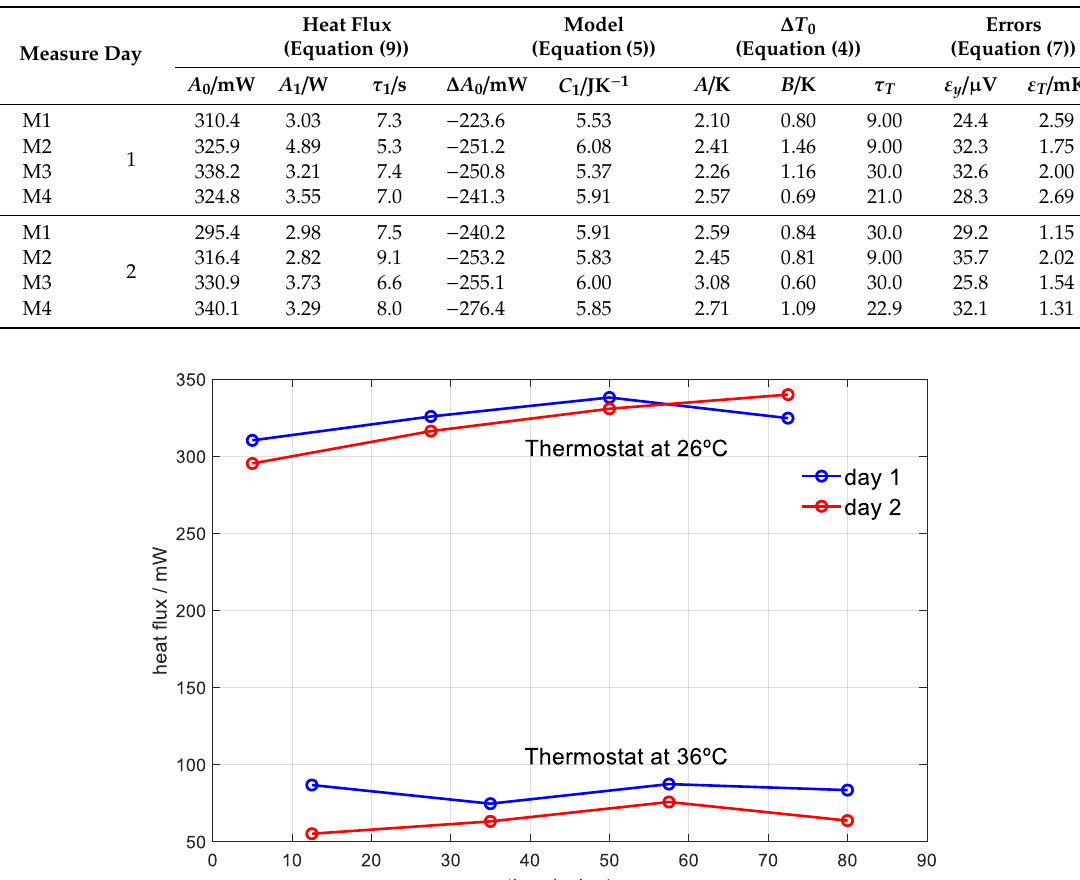
Table 5. Results of measurements made on the temple in the senior subject on two di ff erent days (day 1: T room = 23.3 ◦ C, day 2: T room = 23.5 ◦ C).